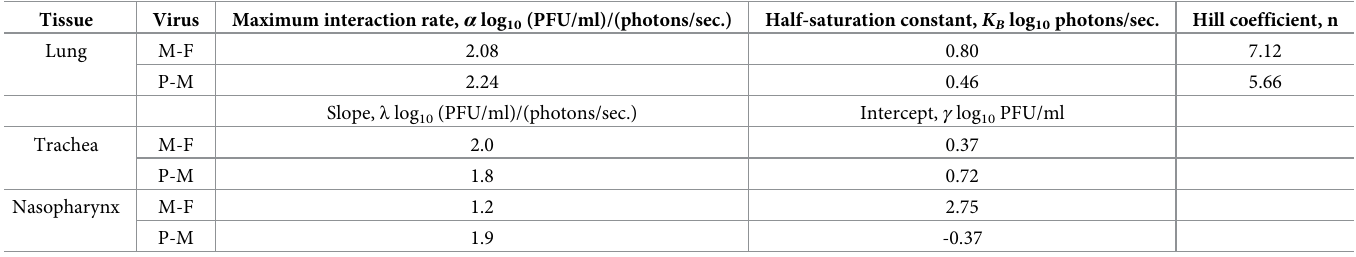
Table 1. Best-fit parameters from translating bioluminescence into viral loads. Parameters obtained by fitting Eq (1) to paired bioluminescence and viral loads from the lung or by fitting Eq (2) to paired bioluminescence and viral loads from the trachea or nasopharynx of individual mice infected with the rSeV-luc(M-F � ) virus (“M-F”) or the rSeV-luc(P-M) virus